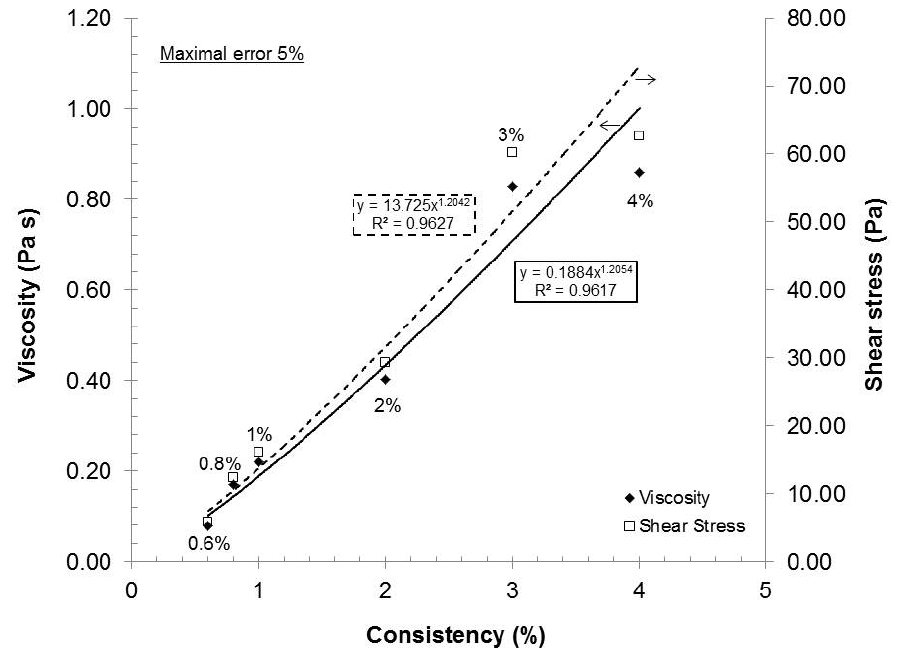
Figure 4. Gel viscosity evolution trend for the various consistencies at shear rate of 73.42 s − 1